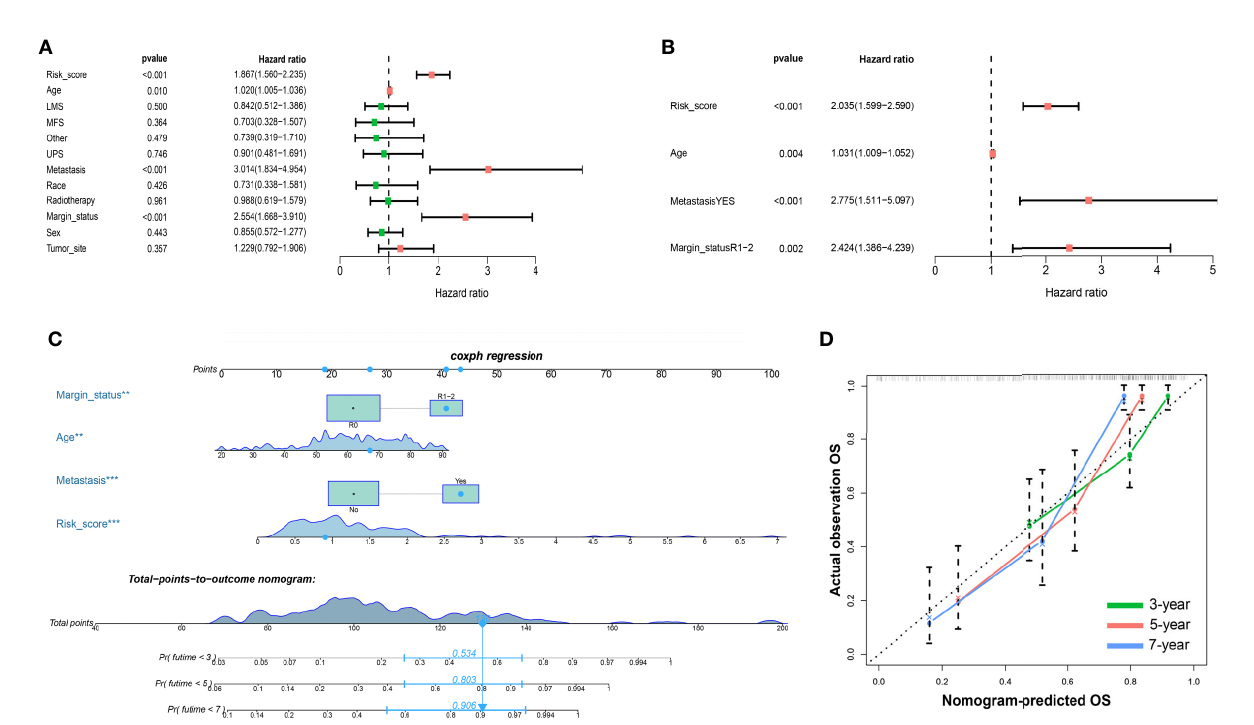
FIGURE 6 | Nomograms based on the OS-related IMRGs for osteosarcoma patients. (A) Univariate Cox analysis of OS-related variables. (B) Multivariate Cox analysis of OS-related variables. (C) Establish a nomogram to predict the OS of patients. (D) The calibration curve shows that using a nomogram to predict OS is highly consistent with actual OS. OS, Overall survival; IMRGs, iron metabolism-related